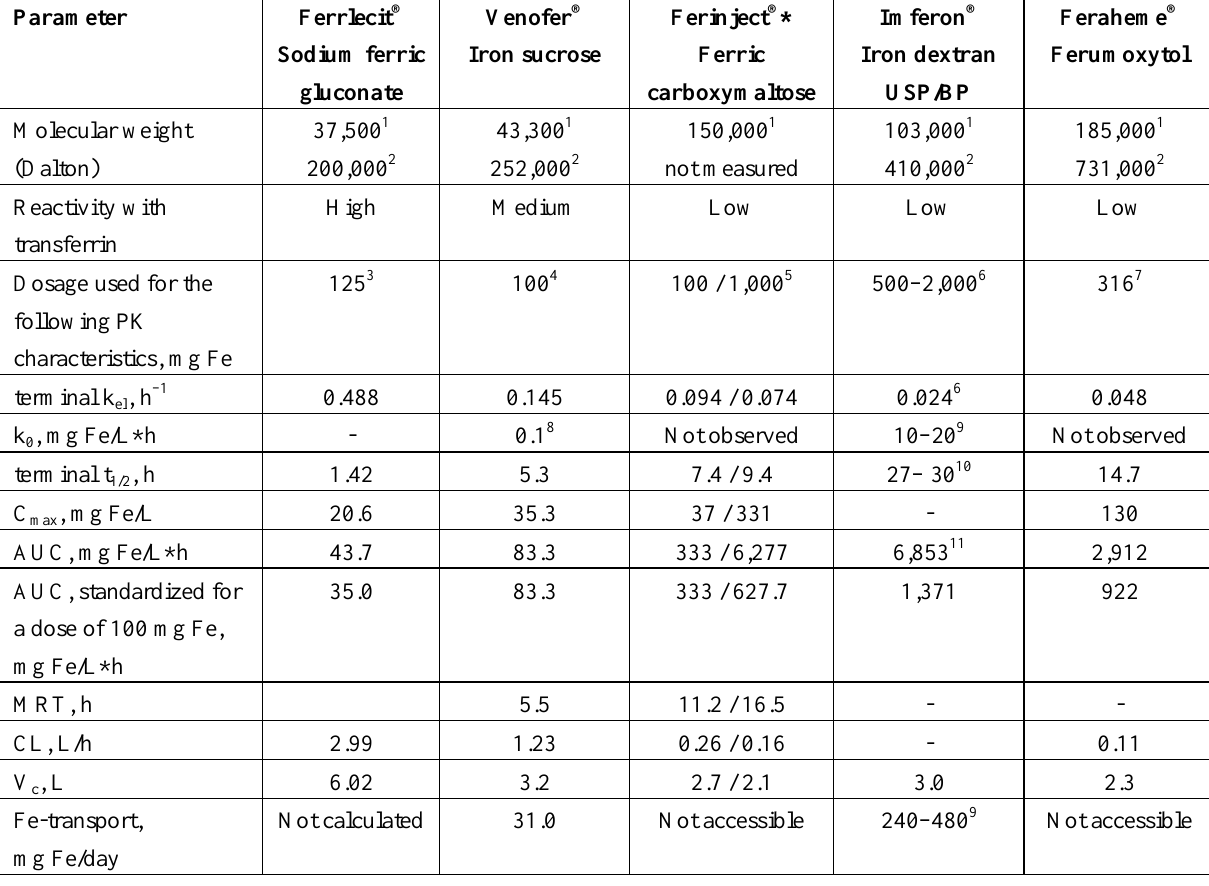
Table 2. Pharmacokinetics parameters for intravenous iron